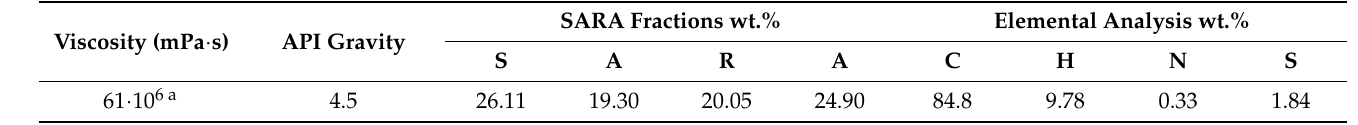
Table 3. Viscosity, density, SARA fractions, and elemental analysis of the studied heavy crude oil. Viscosity (mPa · s) API